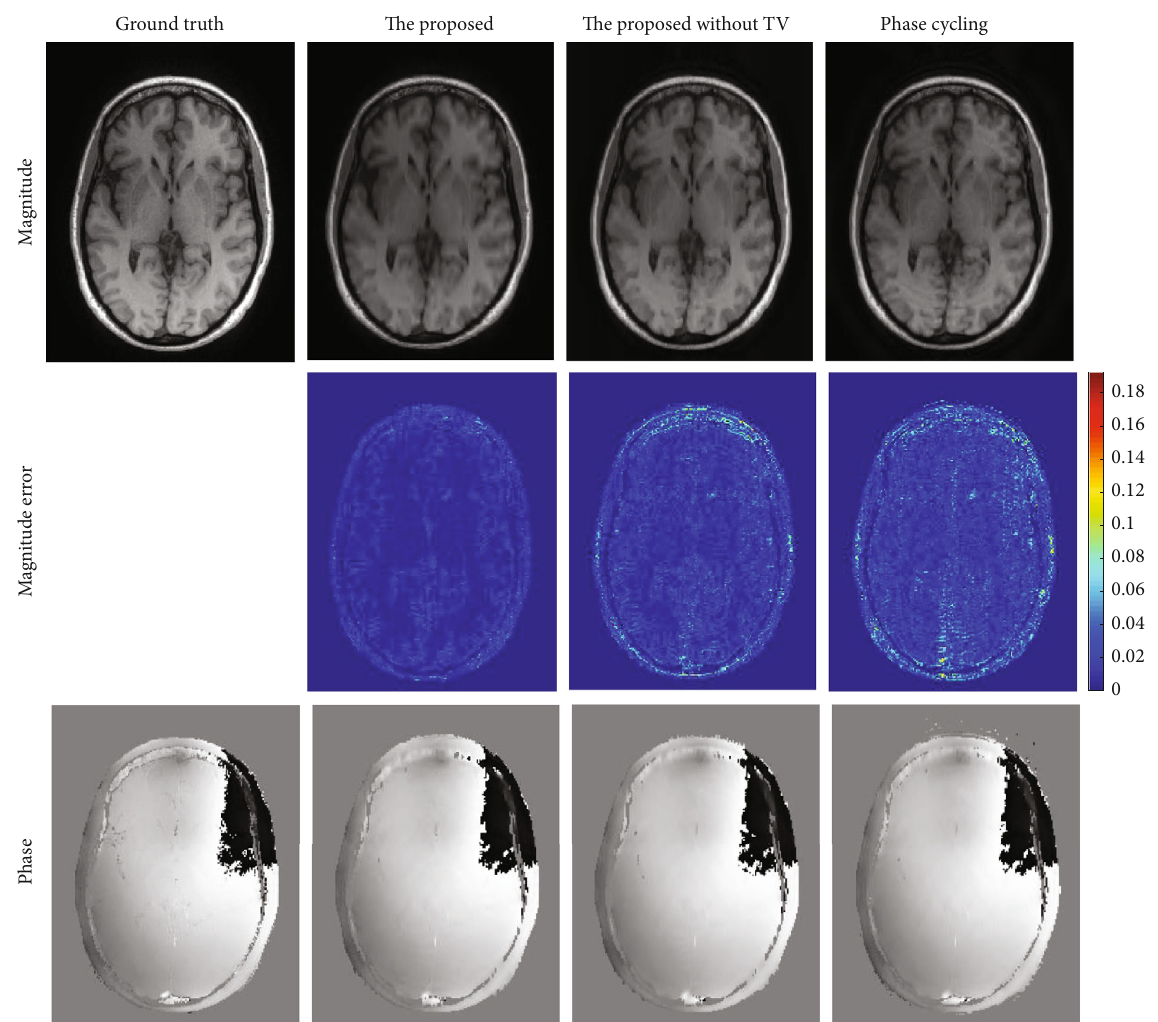
Figure 4: The results on a brain dataset for the proposed algorithm, the proposed method without TV regularization, and the phase cycling